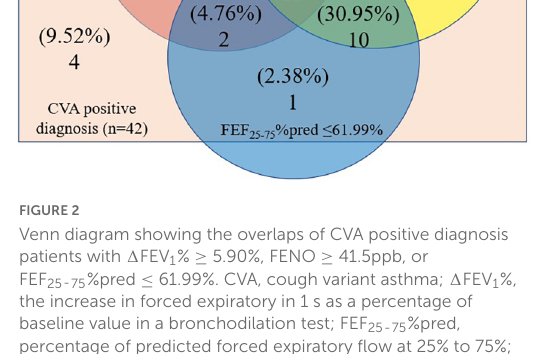
FEF 25 - 75 %pred ≤ 61.99%. CVA, cough variant asthma; (cid:49) FEV 1 %, the increase in forced expiratory in 1 s as a percentage of baseline value in a bronchodilation test; FEF 25 - 75 %pred, percentage of predicted forced expiratory flow at 25% to 75%; FENO, fractional exhaled nitric